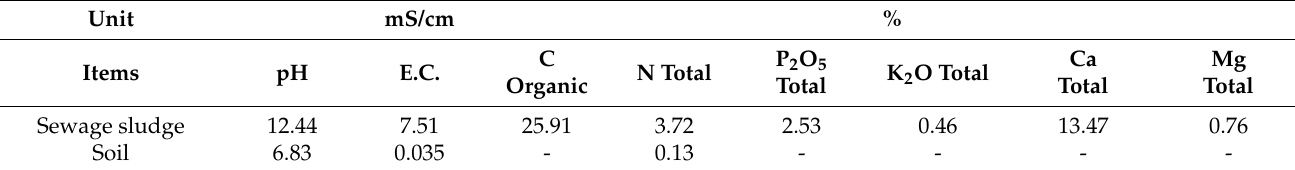
Table 1. Chemical properties of sewage sludge and soil before application of different amounts of sewage sludge.